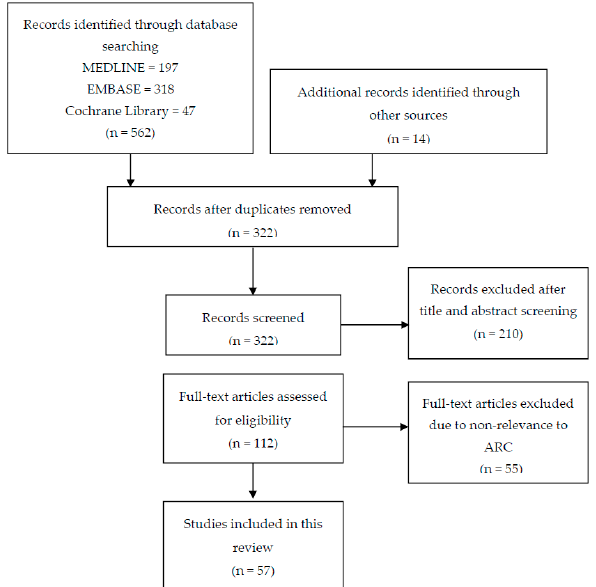
Figure 1. Flow diagram of the literature search for studies addressing augmented renal clearance (ARC).